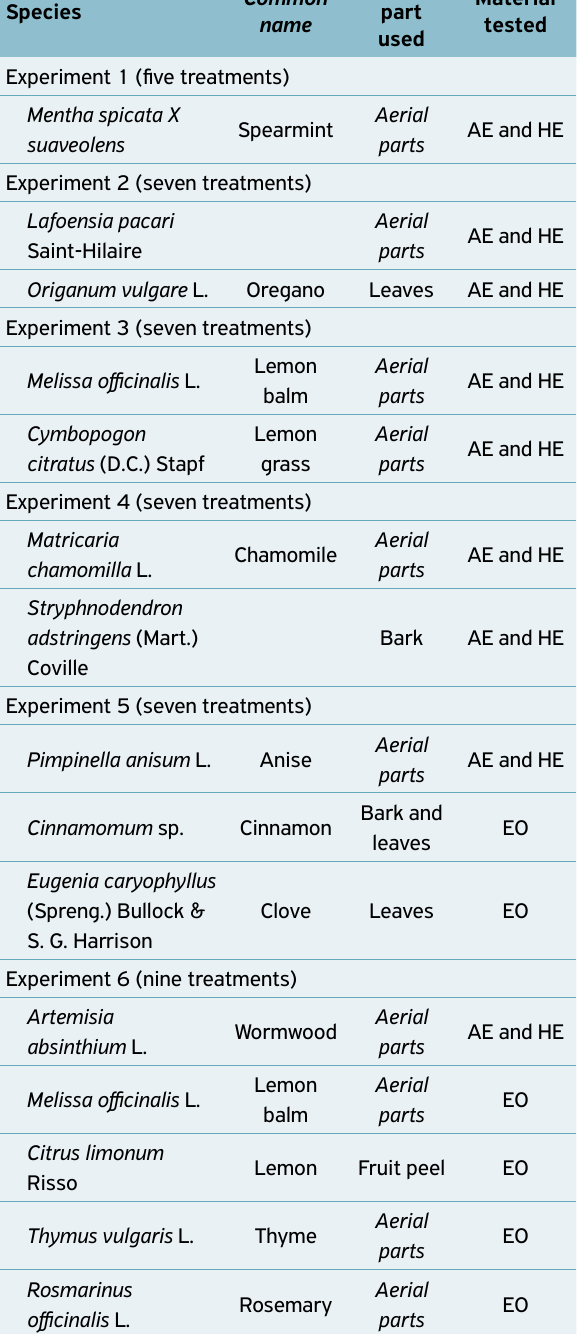
Table 1. Plant extracts and essential oils evaluated